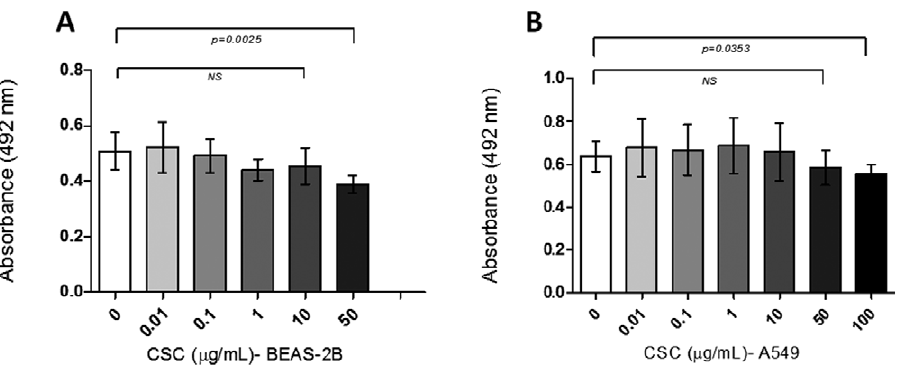
Figure 5. Viability of BEAS-2B (A) and A549 (B) lung cells transfected with pLXSN constructs and exposed to cigarette smoke condensate (range: 0–100 m g/mL) (mean 6 SD, unpaired two-tailed Student’s t-test). NS: Non-significant.